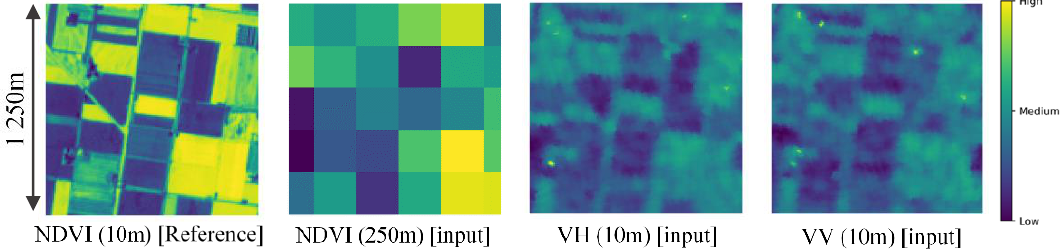
Figure 4. A sample input and output patch pair: ( First panel ) 10-m NDVI from Sentinel-2; ( second ) 250-m NDVI by up-sampling 10-m Sentinel-2; ( third ) 10-m VH from Sentinel-1; ( fourth ) 10-m VV from Sentinel-1.